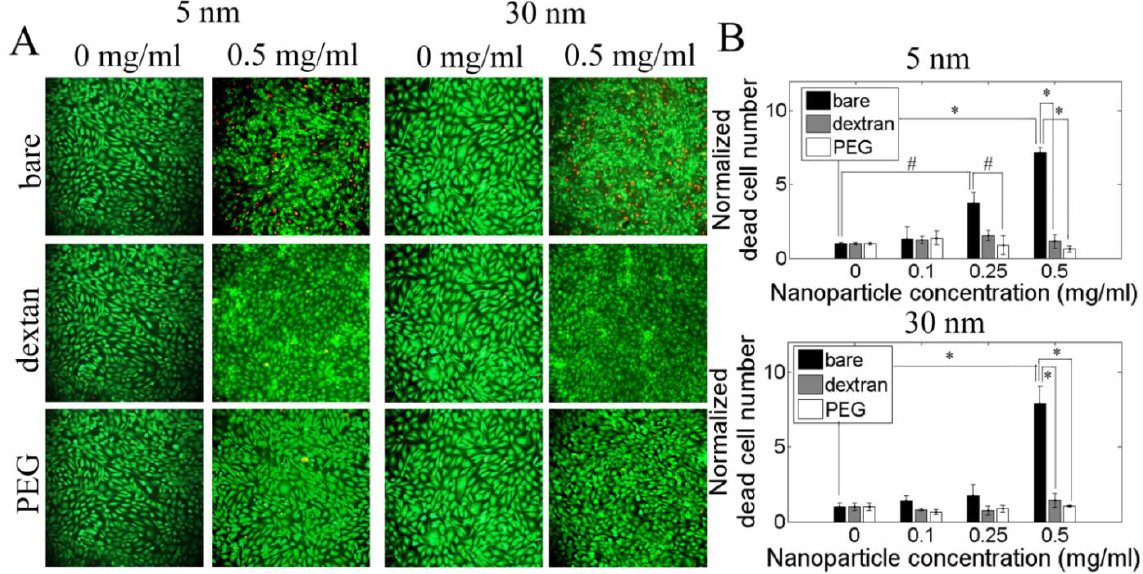
Figure 3. Dextran and PEG coating reduced iron oxide nanoparticle cytotoxicity, as measured by a Live/Dead assay. PAEC were incubated with 0, 0.1, 0.25 and 0.5 mg/mL of 5 and 30 nm bare and coated nanoparticles for 24 h. ( A ) Selected fluorescent images in which green = live cells and red = dead cells; and ( B ) Quantification of dead cell number by Image J. * p < 0.01, # p <